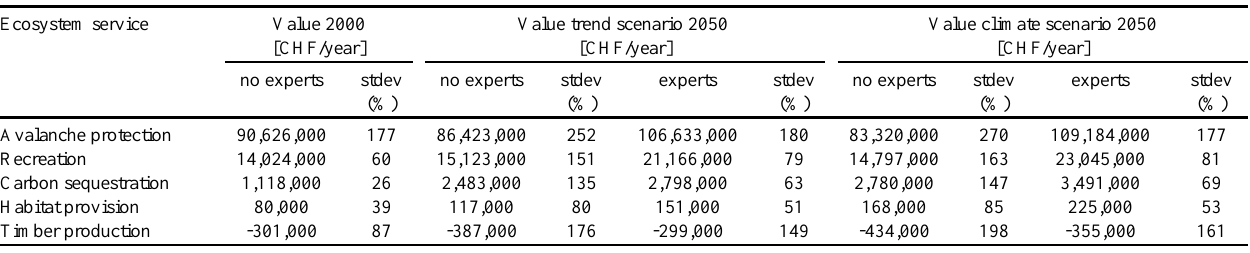
Table 1 . Expected values and related uncertainties of selected forest ecosystem services in the region of Davos, Switzerland under different scenarios, calculated with a Bayesian network in which variables were not updated (no experts) or updated (experts) by an expert survey. Standard deviations (stdev) are given as percentages of the expected ecosystem services values. Ecosystem service Value 2000 Value trend scenario 2050 Value climate scenario 2050 [CHF/year] [CHF/year] [CHF/year] no experts stdev no experts stdev experts stdev no experts stdev experts stdev (%) (%) (%) (%) (%) Avalanche protection 90,626,000